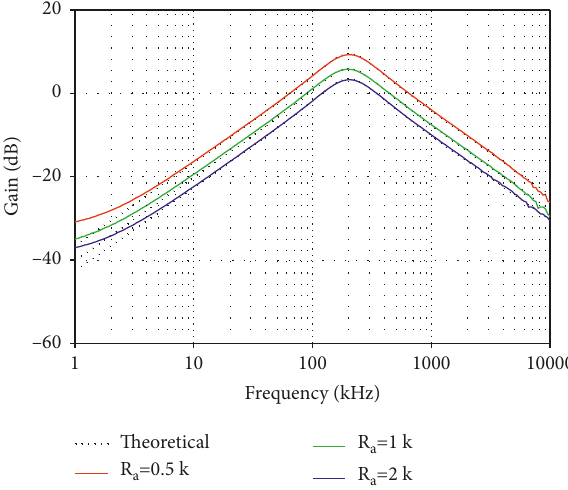
Figure 13: Experimental magnitude frequency response of BP function when R a is varied.